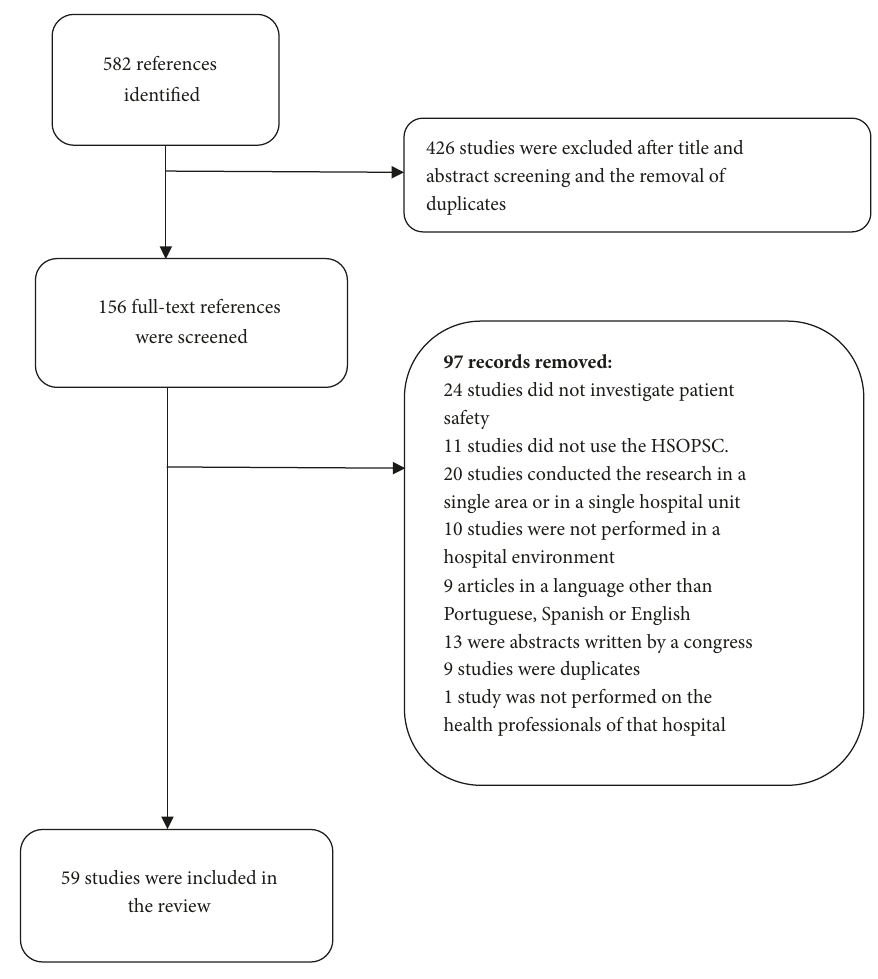
Figure 1: Flowchart of included studies.